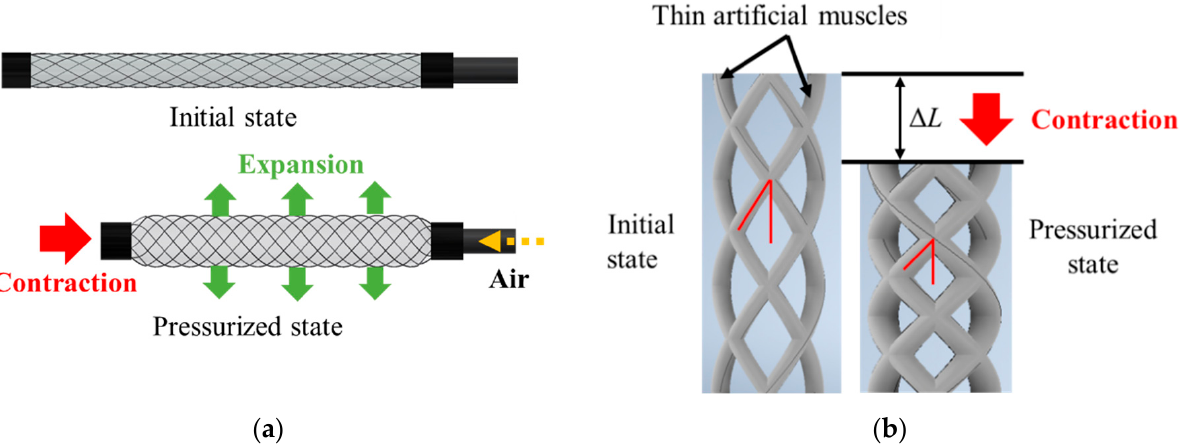
Figure 4. Contraction of the active string actuator: ( a ) contraction of the thin artificial muscle; ( b ) contraction using the pantograph mechanism.